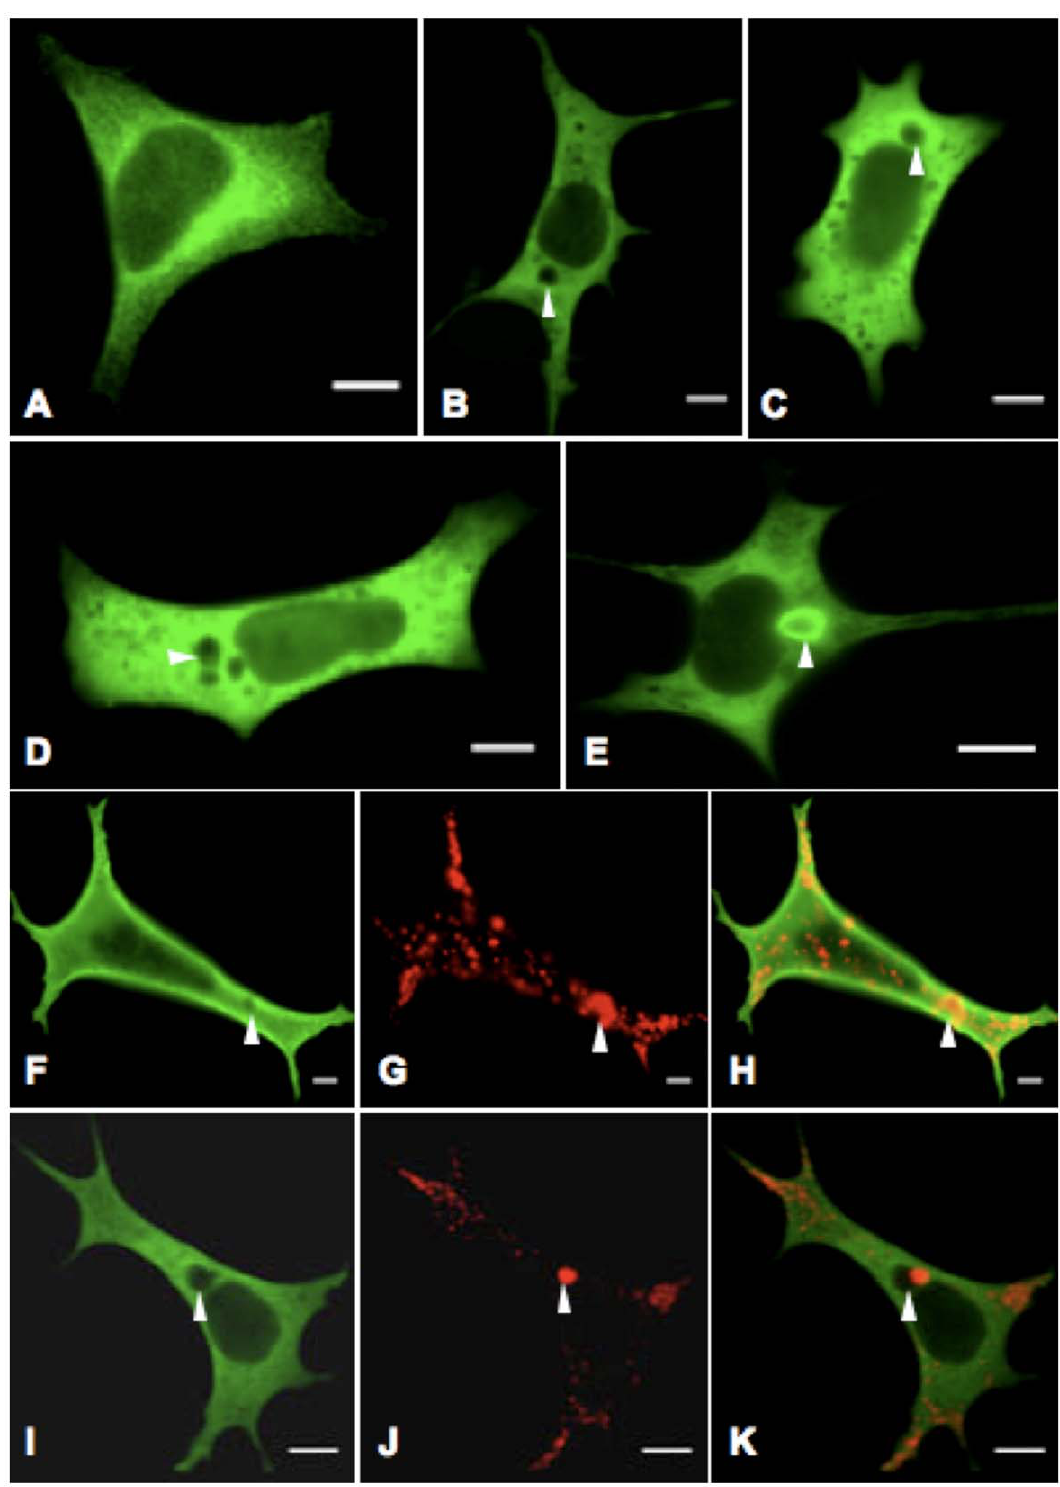
Figure 6. Overexpression of mutant CHMP2B produces an aberrant phenotype in HEK-293 cells. Cells were transfected with vectors encoding recombinant protein c-Myc-CHMP2B with either the wild-type or I29V, T104N or Q206H mutant sequence, and stained with FITC-conjugated antibody to c-Myc. Transfection with wild-type CHMP2B (A) results in generalised cytoplasmic expression, whereas the mutant isoforms I29V (B), T104N (C) and Q206H (D) resulted in cytoplasmic vacuoles of varying size (indicated by arrowheads). Another striking observation was the presence within cells expression mutant CHMP2B of circular CHMP2B accumulations in the cytoplasm, termed halos (E). Cells were doubly stained with antibodies to c-Myc (F & I), as well as CD63 (G & J), and merged to show co-localisation (H & K). CD63 co-localises with the small vacuoles found in cells transfected with WT CHMP2B (F–H). However, CD63 staining does not co-localise with large vacuoles in mutant expressing cells (cells transfected with T104N shown), but are found on the vacuole edge (I–K). Images were taken on a Zeiss LSM 510 confocal microscope, 6 63 obj. Bar, 10 m m.